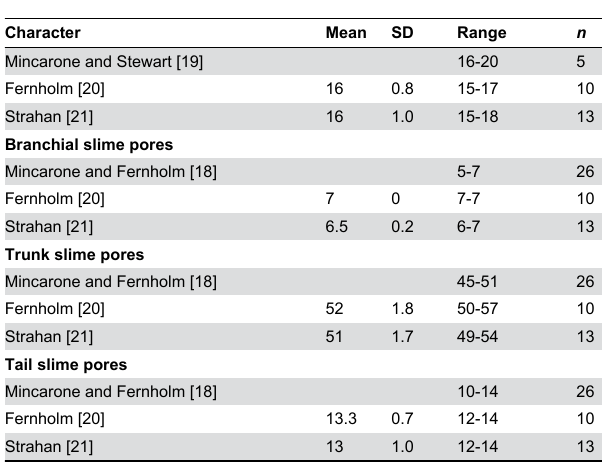
Table 3. Morphometric data reported for E. cirrhatus in other studies.